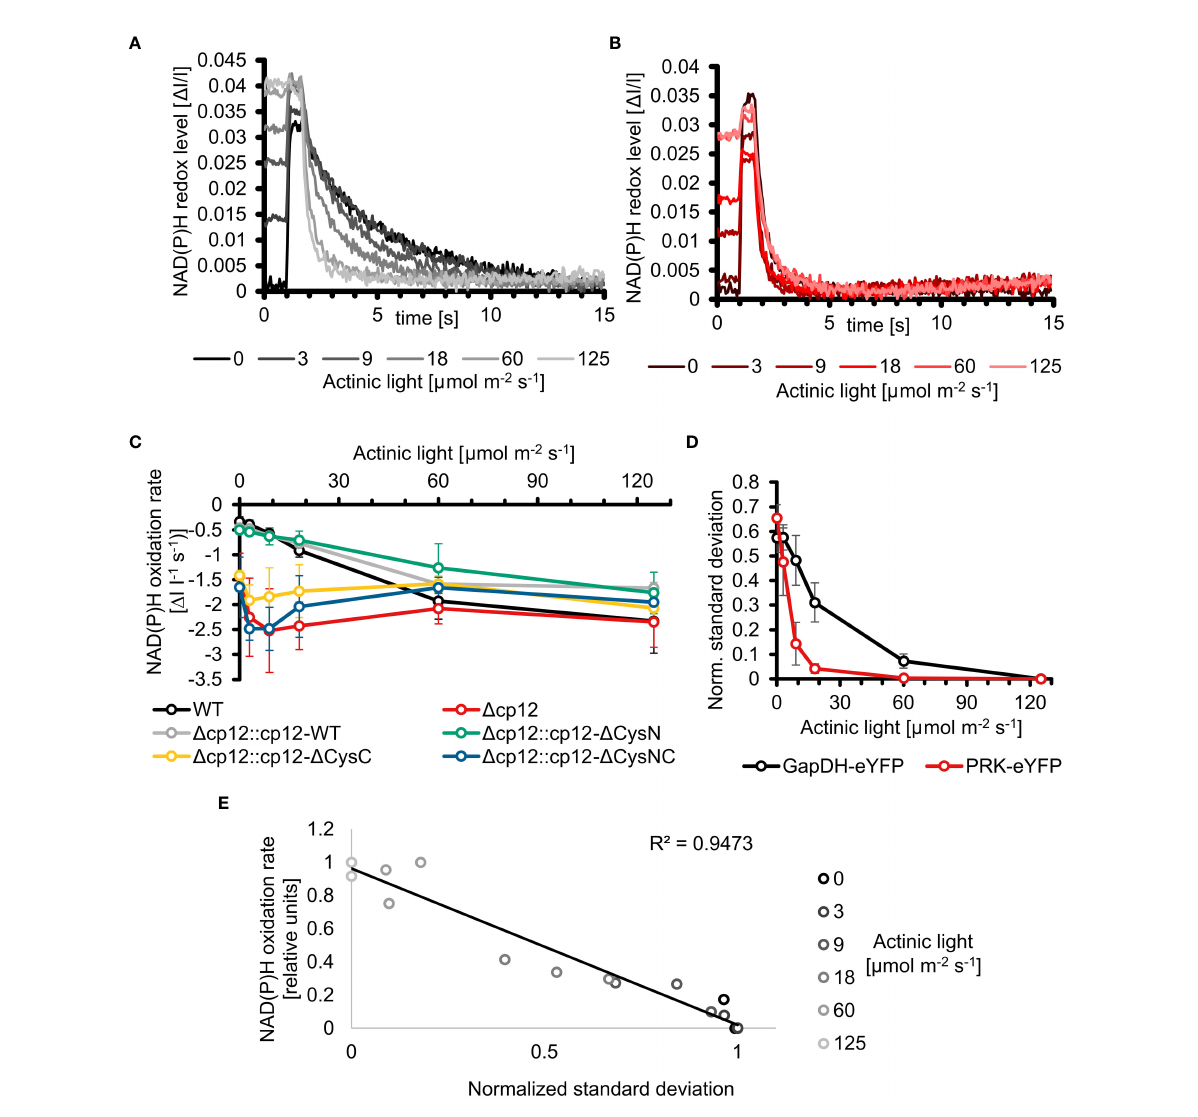
FIGURE 6 Redox changes in the Synechocystis wild type and mutant D cp12 under different light conditions. (A, B) NAD(P)H redox changes measured in vivo via NAD(P)H fl uorescence in wild-type (WT) (A) or mutant D cp12 cells (B) . The NAD(P)H pool was reduced to its maximum with a strong actinic light pulse (600 ms) and its re-oxidation in darkness was observed. The measured cells were pre-acclimated to the 5 different actinic light intensities or to darkness. (C) NAD(P)H oxidation rates of strains expressing different CP12 variants after pre-acclimation to different actinic light intensities. (D) Normalized standard deviations representing the heterogeneity of fl uorescence signal distribution inside cells. The distribution of PRK-eYFP and GapDH-eYFP is measured under different actinic light conditions. (E) Scatterplot of the normalized standard deviation of GapDH-eYFP vs the NAD(P)H oxidation rate under different light